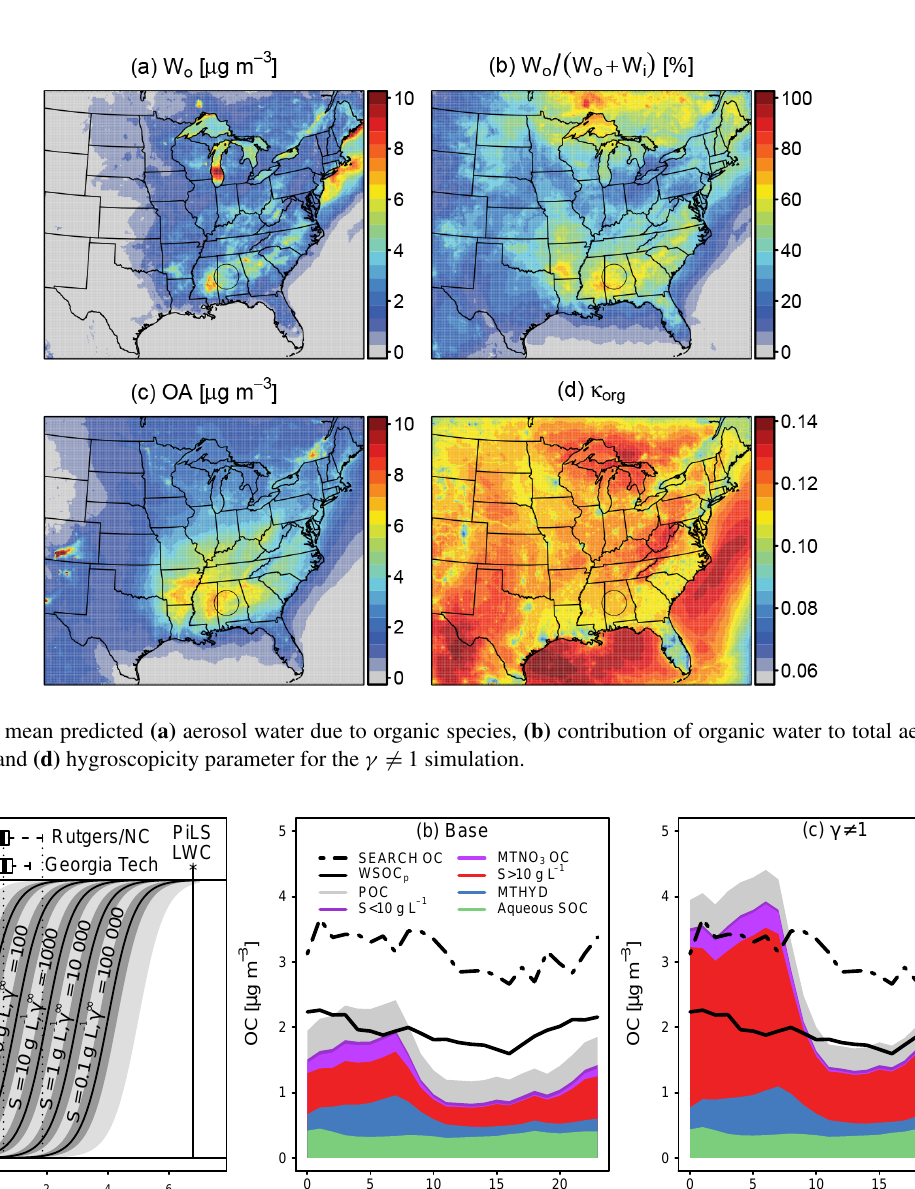
o f on t i a c F r